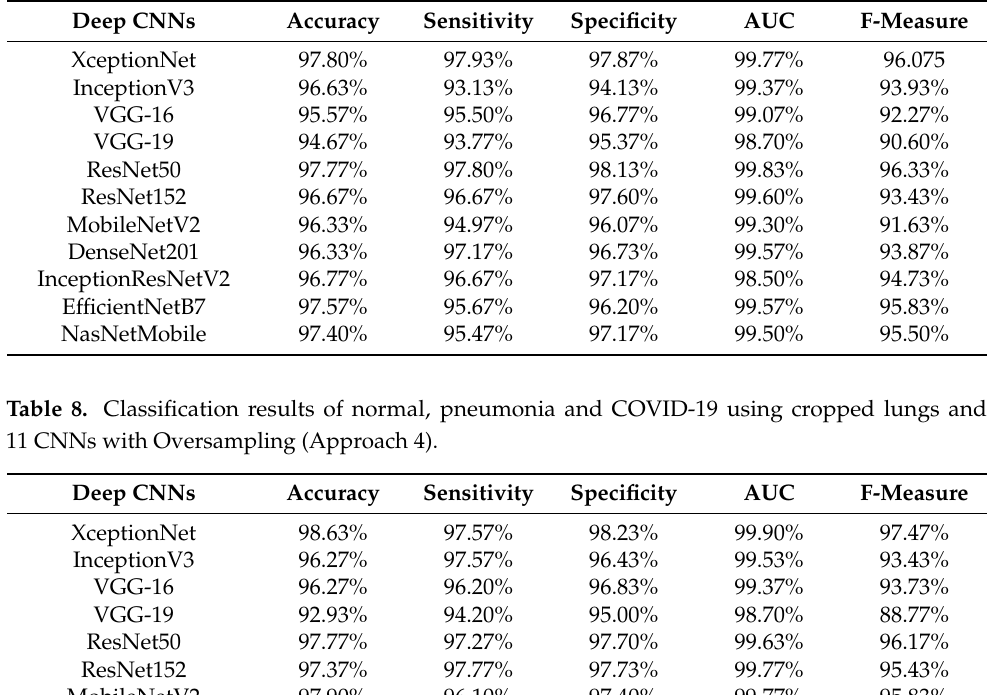
Table 7. Classification results of normal and pneumonia and COVID-19 using cropped lungs and 11 CNNs with Undersampling (Approach 3).